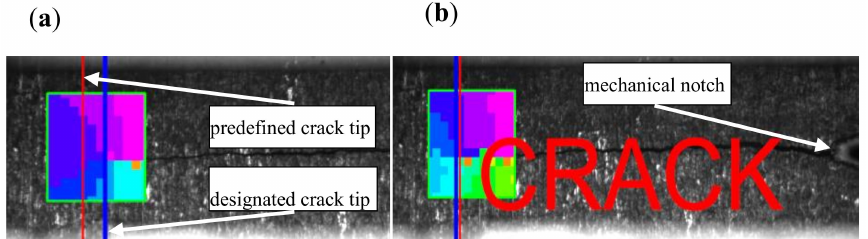
Figure 2. Scheme of the fracture peak identification, ( a ) top of the fracture before the borderline and ( b ) top of the fracture behind the